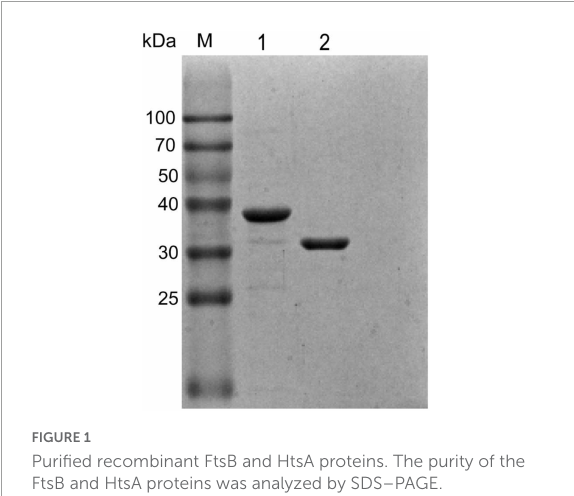
FIGURE1 Purified recombinant FtsB and HtsA proteins. The purity of the FtsB and HtsA proteins was analyzed by SDS–PAGE. M represents the protein marker, line 1 represents the HtsA protein, and line 2 represents the FtsB protein.